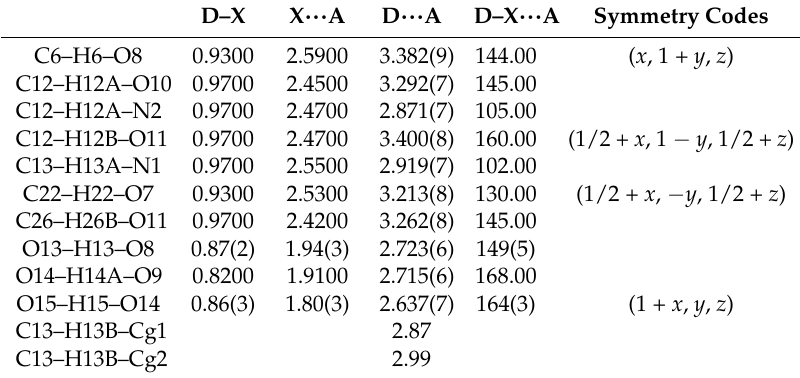
Table 3. Hydrogen bonding interactions (Å, ◦ ) of the